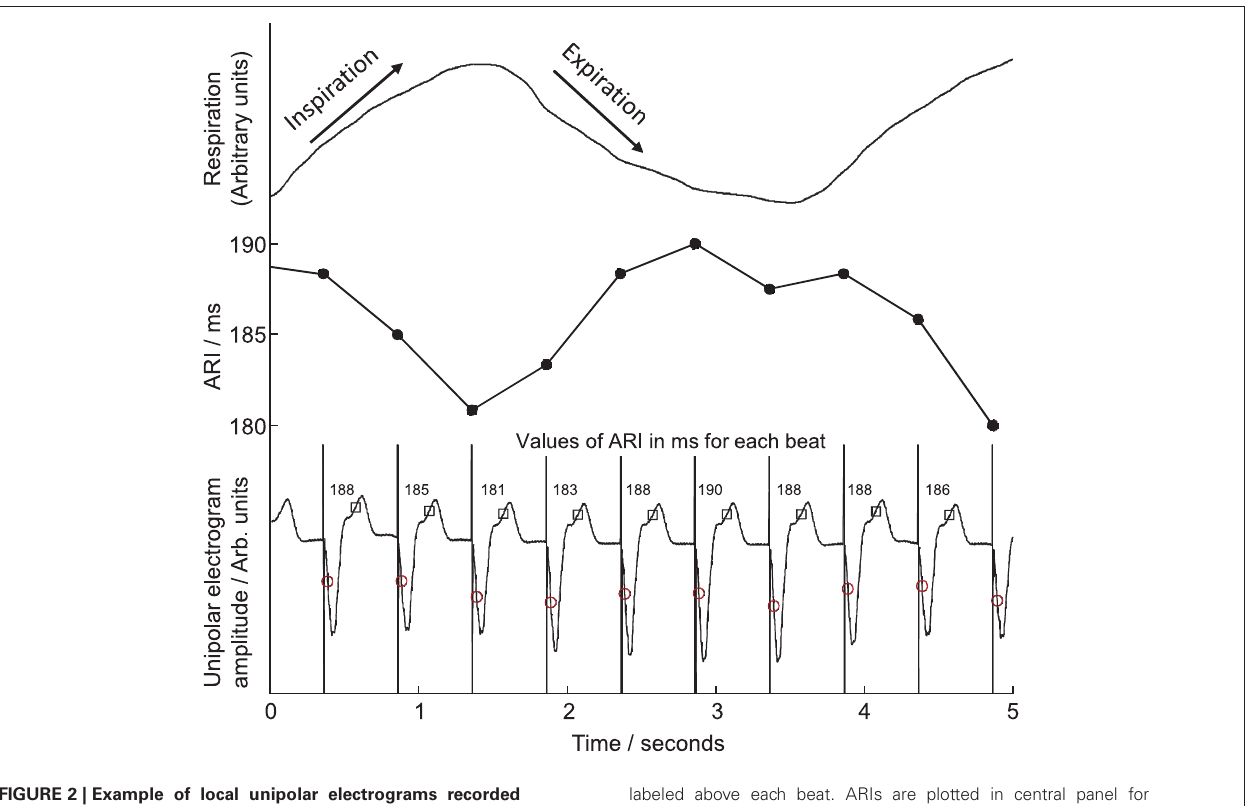
FIGURE 2 | Example of local unipolar electrograms recorded from an electrode site on the right ventricular endocardium. Times of local activation are marked with circles, repolarization with squares, activation-repolarization intervals (ARIs) are